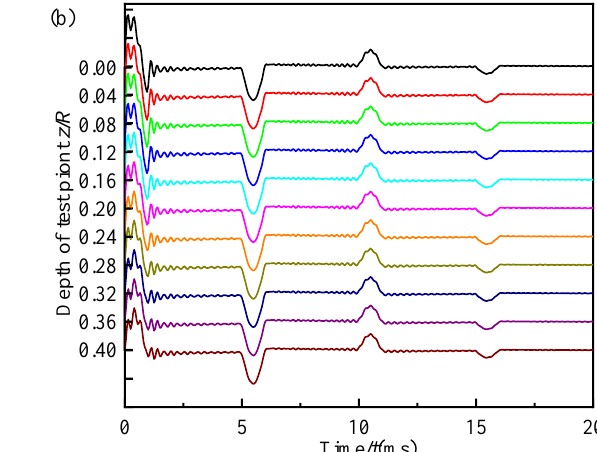
Figure 13. Location of the test points in the vertical direction.